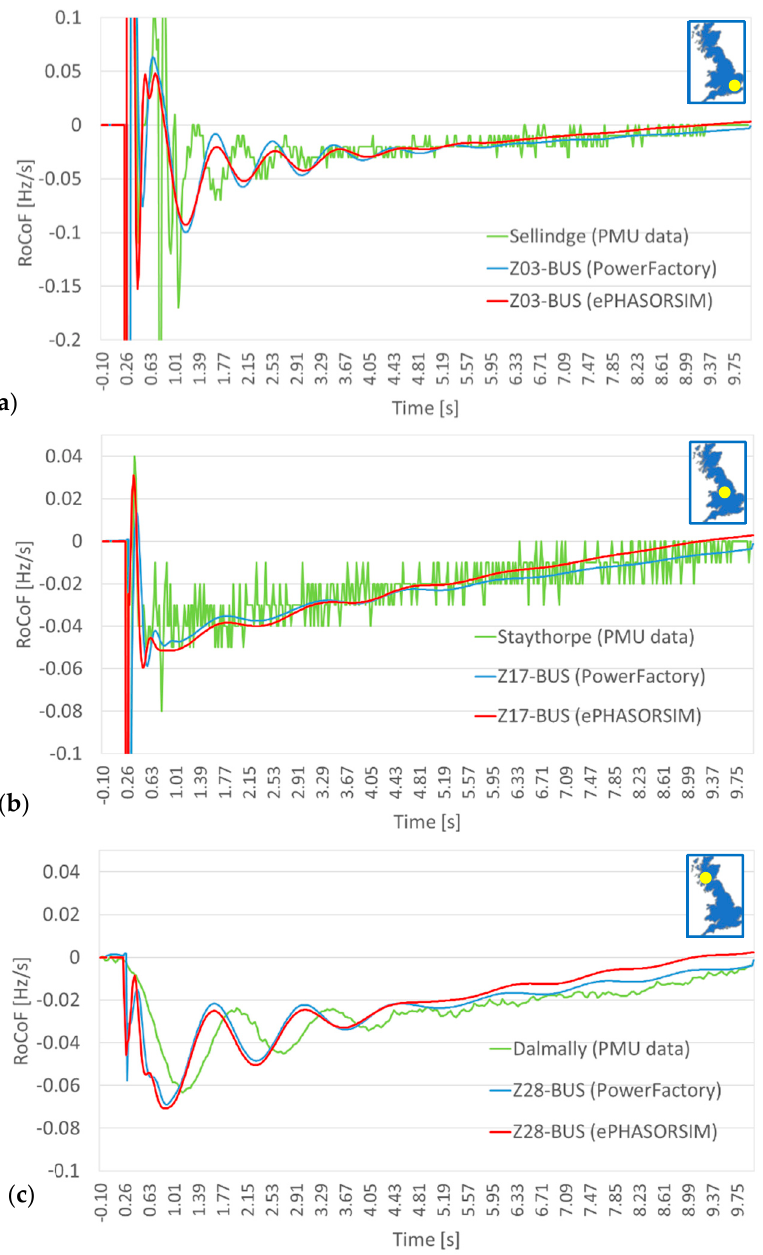
Figure 13. Comparison of PMU data with reduced system simulations in PowerFactory and ePHAS- ORSIM for the HVDC trip: ( a ) Zone 03 with Sellindge PMU data, ( b ) Zone 17 with Staythorpe PMU data, and ( c ) for Zone 28 with Dalmally PMU data.